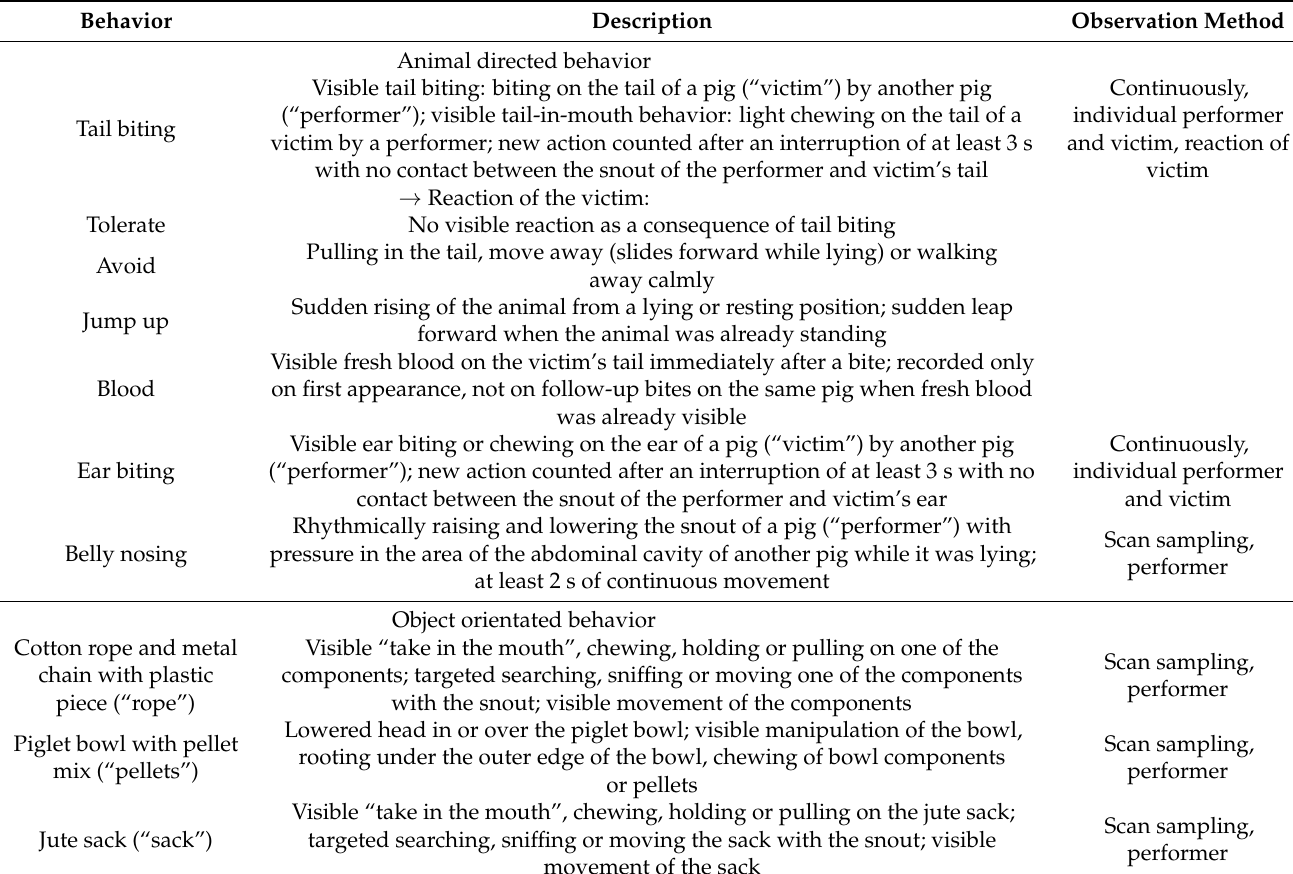
Table 4. Ethogram of the behavioral traits of the pigs during